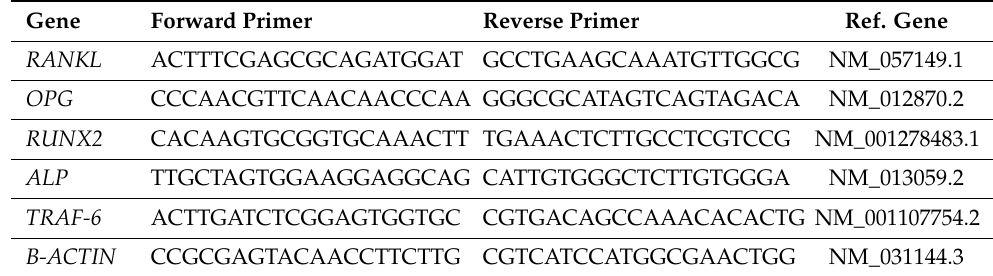
Table 1. Primers of genes used for real-time PCR on femur